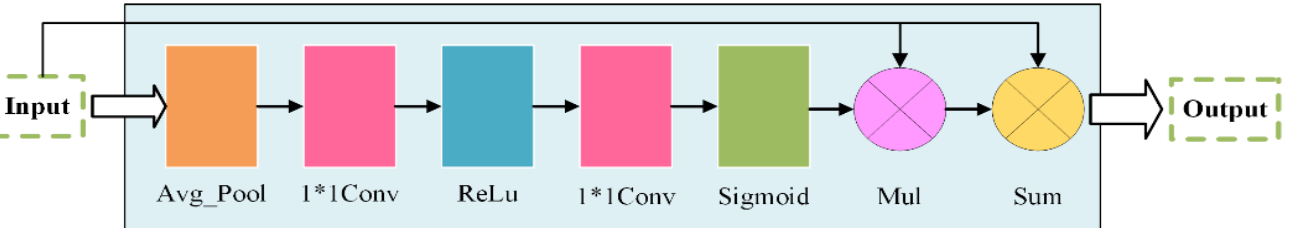
Figure 3. Global information enhancement module.